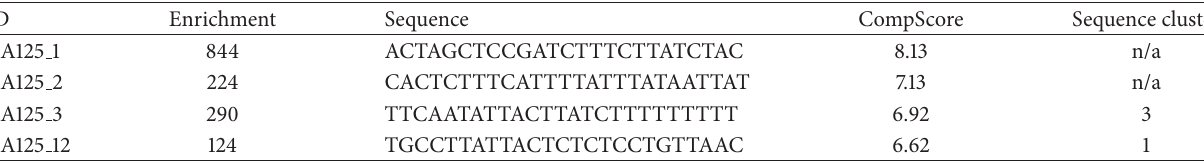
Table 2: CA125 aptamer candidates chosen for in vitro analysis. Aptamers candidates were named based on their enrichment rank; for example, CA125 1 is the sequence that was most enriched in Round 4 relative to the unselected library (Round 0). Note that CA125 2 is a 26 mer; indels of plus or minus one base were tolerated in our bioinformatics analysis. n/a: not available.